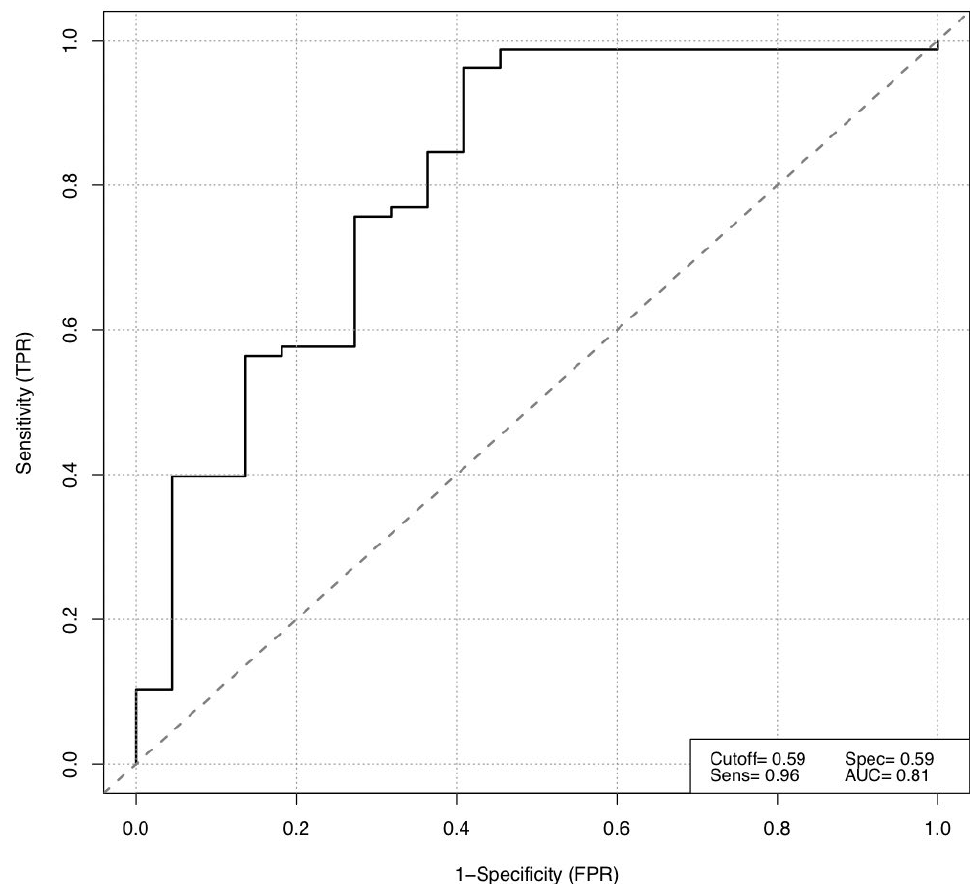
Figure 2. Receiver operating characteristic (ROC) of our binominal backward regression model (logit model) for short-term response prediction in metastatic melanoma patients treated for six months with immune checkpoint inhibition.